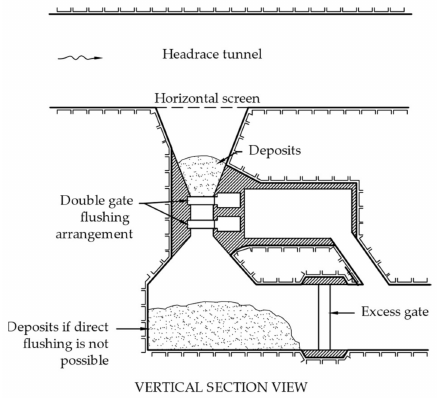
Figure 8. Flushing rock trap with excess tunnel below the main